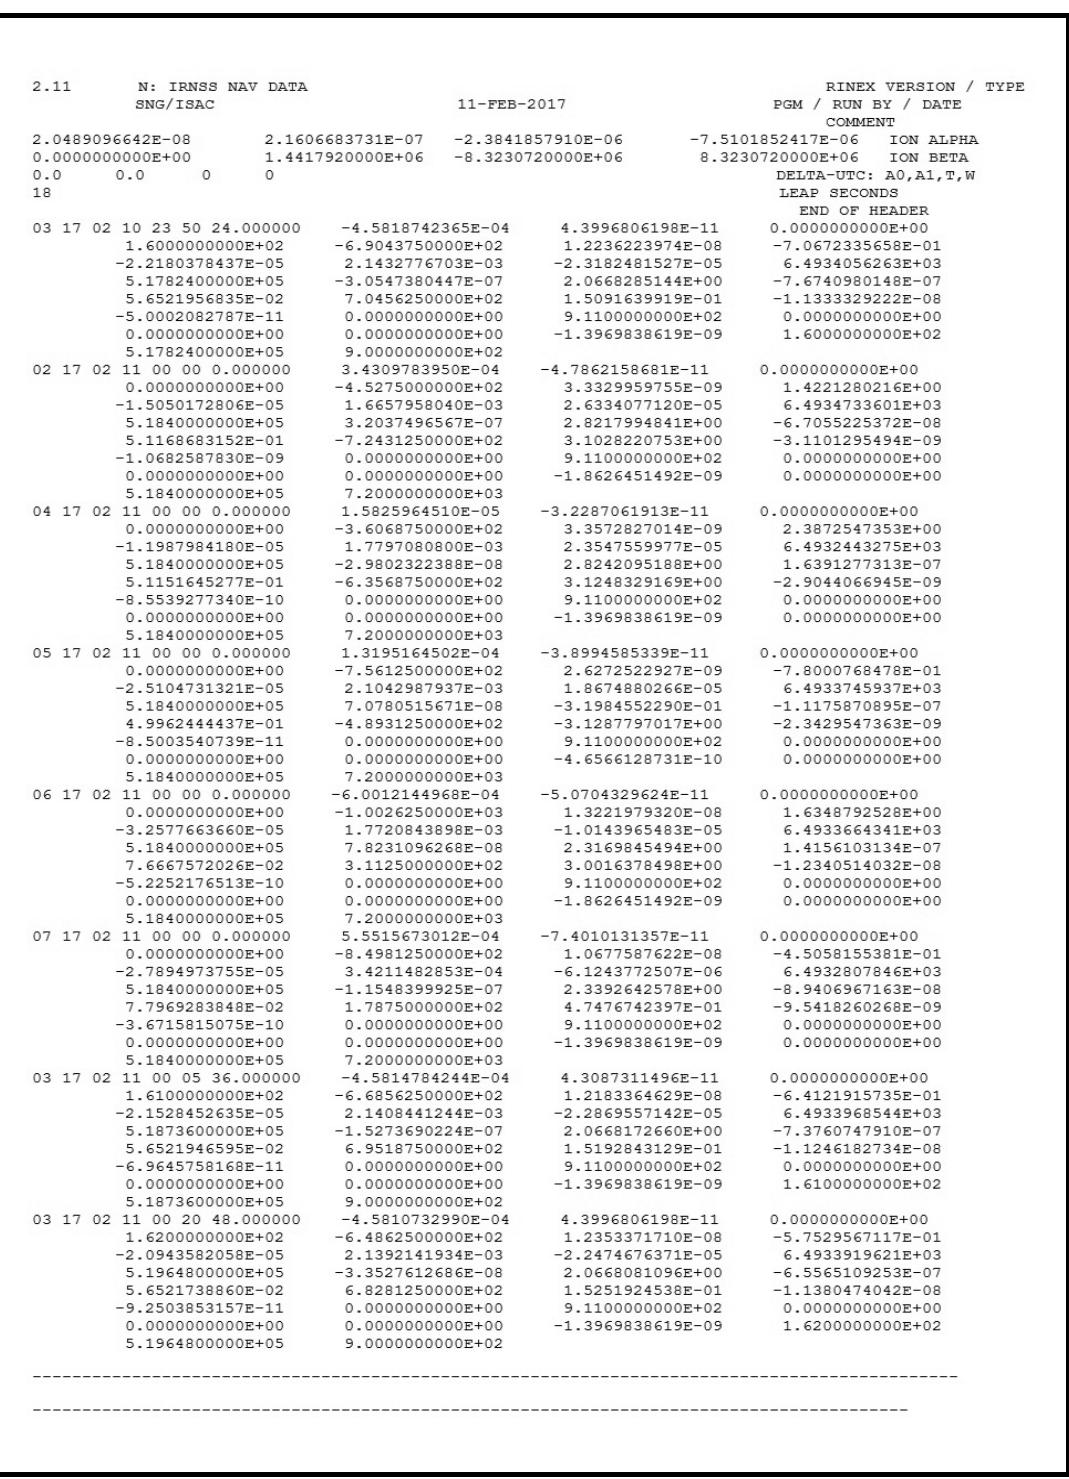
Fig. 2. IRNSS navigation data in RINEX